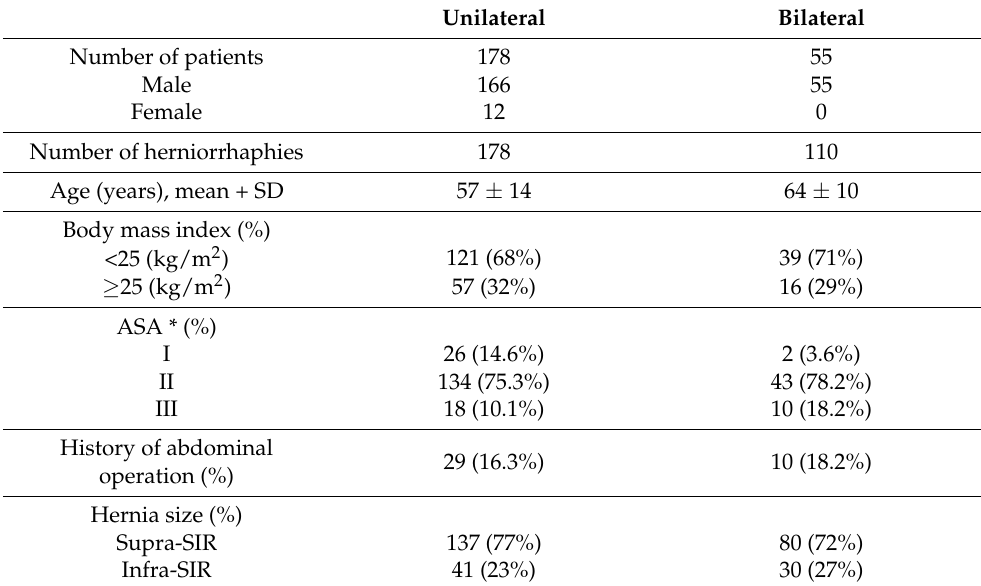
Table 1. Patients’ demographics and hernia characteristics.